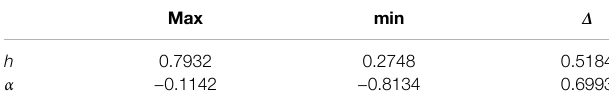
TABLE 2 | Multifractal parameters Δ h and Δα